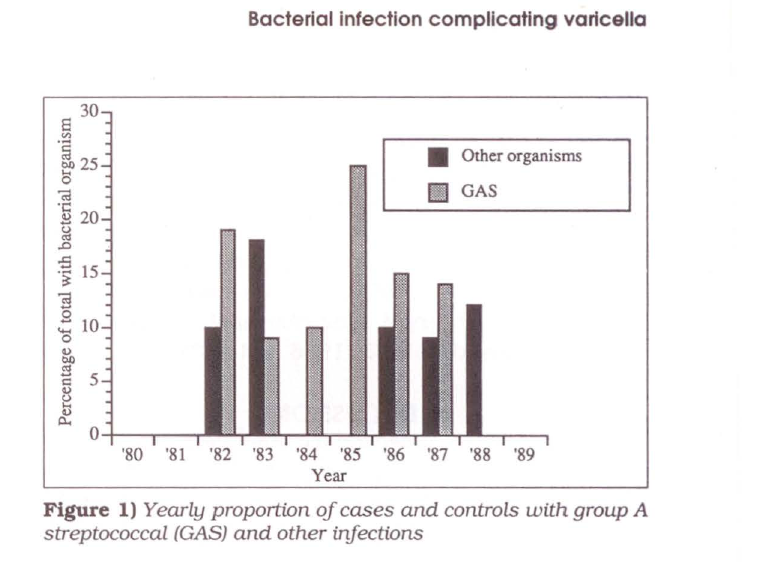
Figure 1) Yearly proportion of cases and controls with group A streptococcal (GAS) and other infections